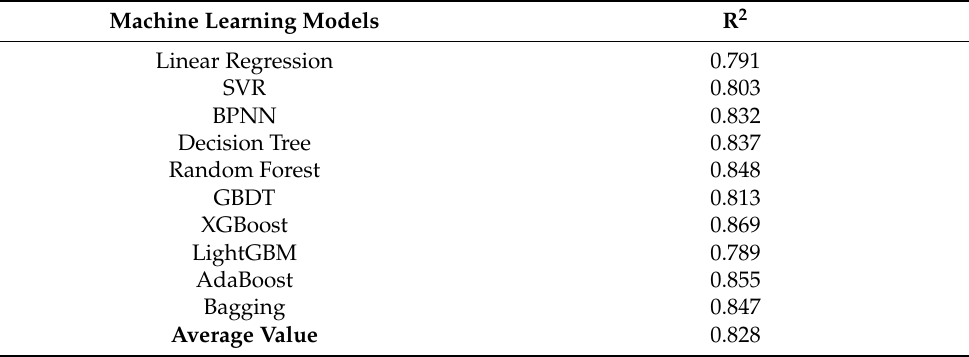
Table 8. R-squared of machine learning